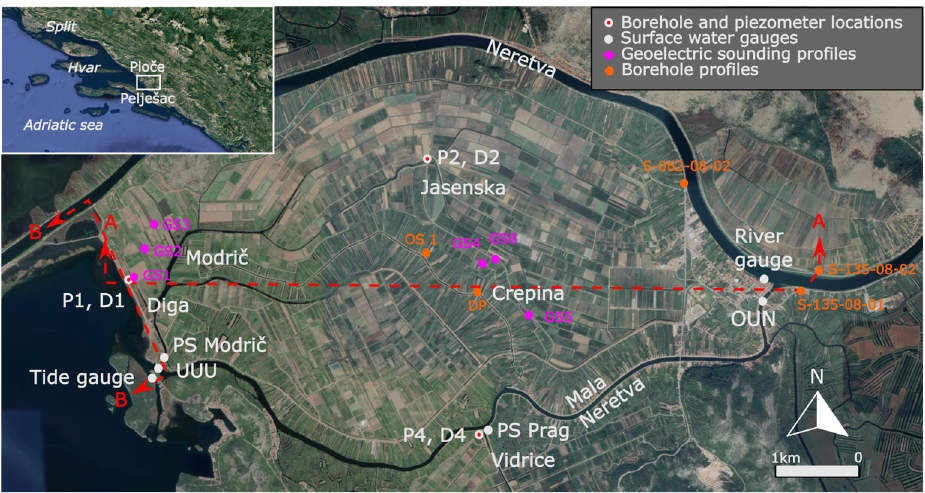
Figure 1. River Neretva valley area of interest with locations of boreholes, observation piezometers, surface water gauges, and geological